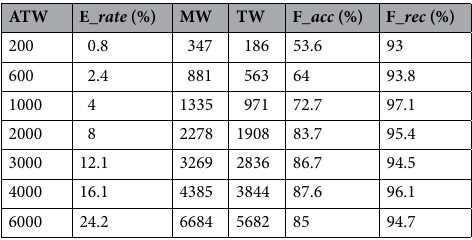
Table 6. Noise image screening results of in-class labels.